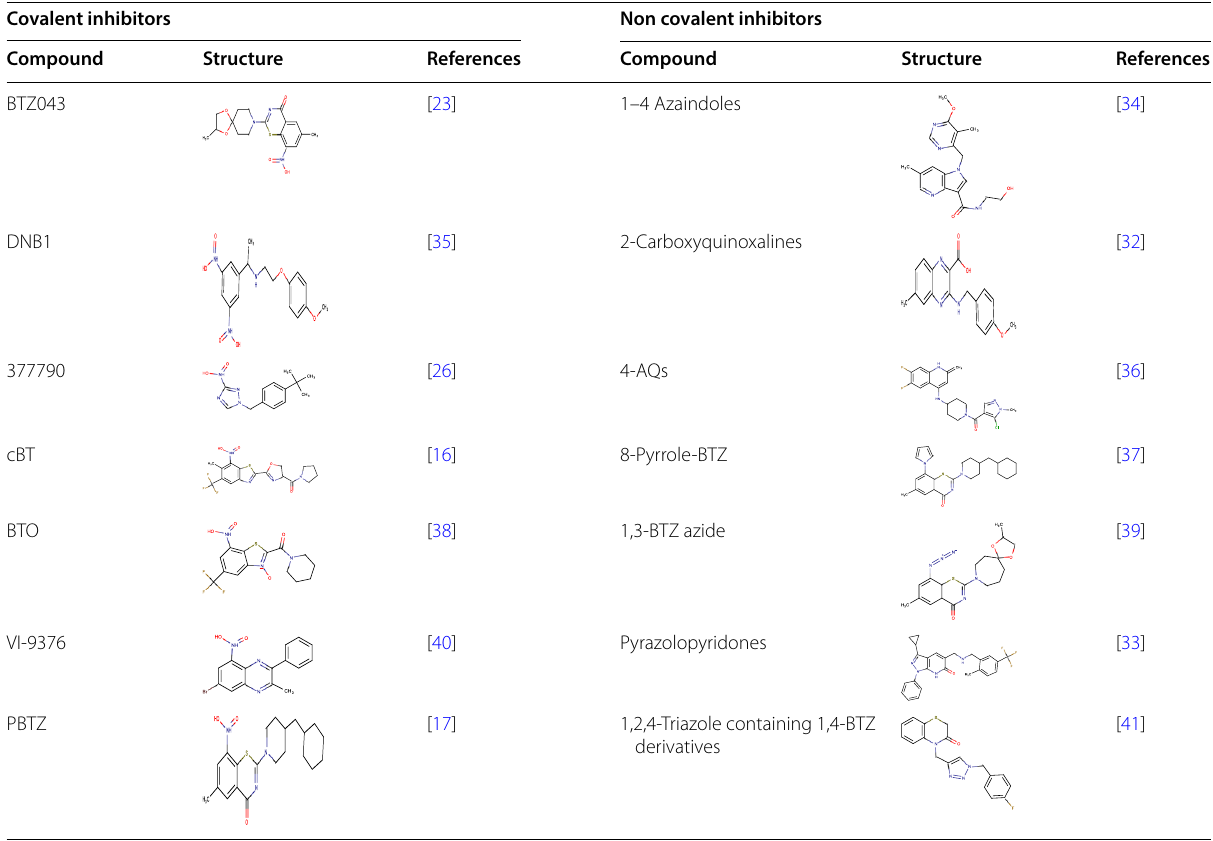
Table 1 Covalent and non‑covalent DprE1inhibitors Covalent inhibitors Non covalent